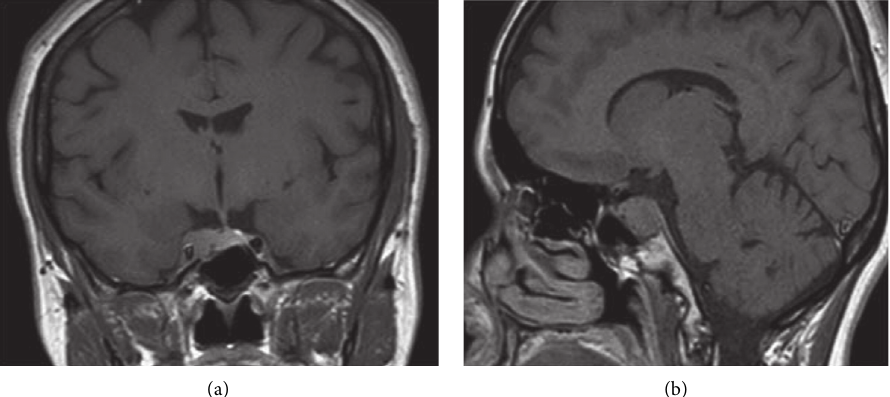
Figure 3: Coronal (a) and sagittal (b) images of pituitary MRI showing 10mm hypoenhancing adenoma with invasion of the right cavernous sinus.